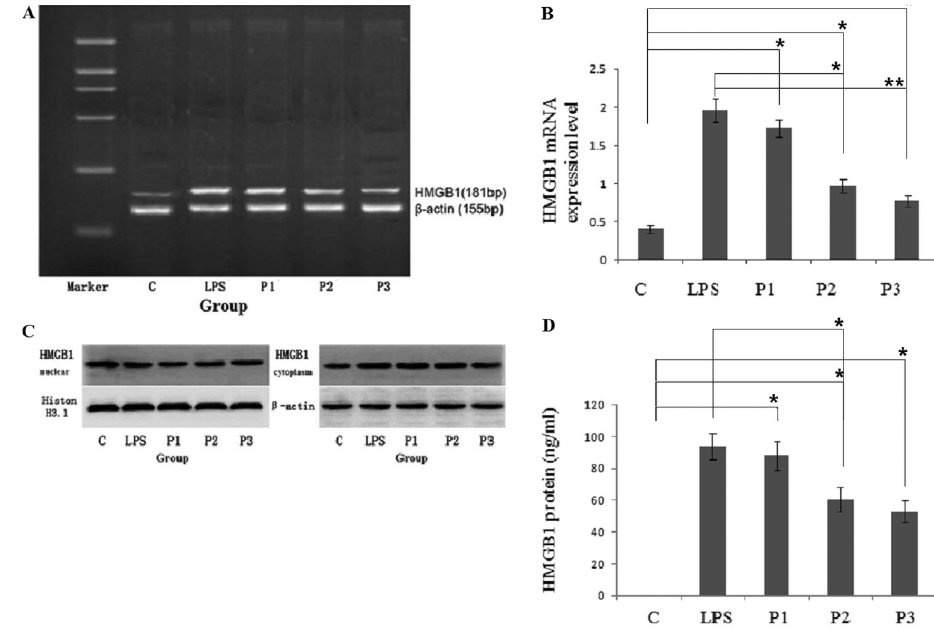
Figure 1. Gel electrophoresis of HMGB1 mRNA and HMGB1 protein levels in each group. A , B , Gel electrophoresis of HMGB1 mRNA; C , HMGB1 protein levels in cell nucleus and cytoplasm; D , HMGB1 protein levels in cytoplasm. *P , 0.05; **P , 0.001 (ANOVA). Groups: C, negative control; LPS, treated with 500 ng/mL lipopolysaccharide (LPS); P1, treated with 500 ng/mL LPS and equal quantity of fat emulsion; P2, treated with 500 ng/mL LPS and 25 m mol/mL propofol; P3, treated with 500 ng/mL LPS and 50 m mol/mL propofol. HMGB1: high-mobility group box 1